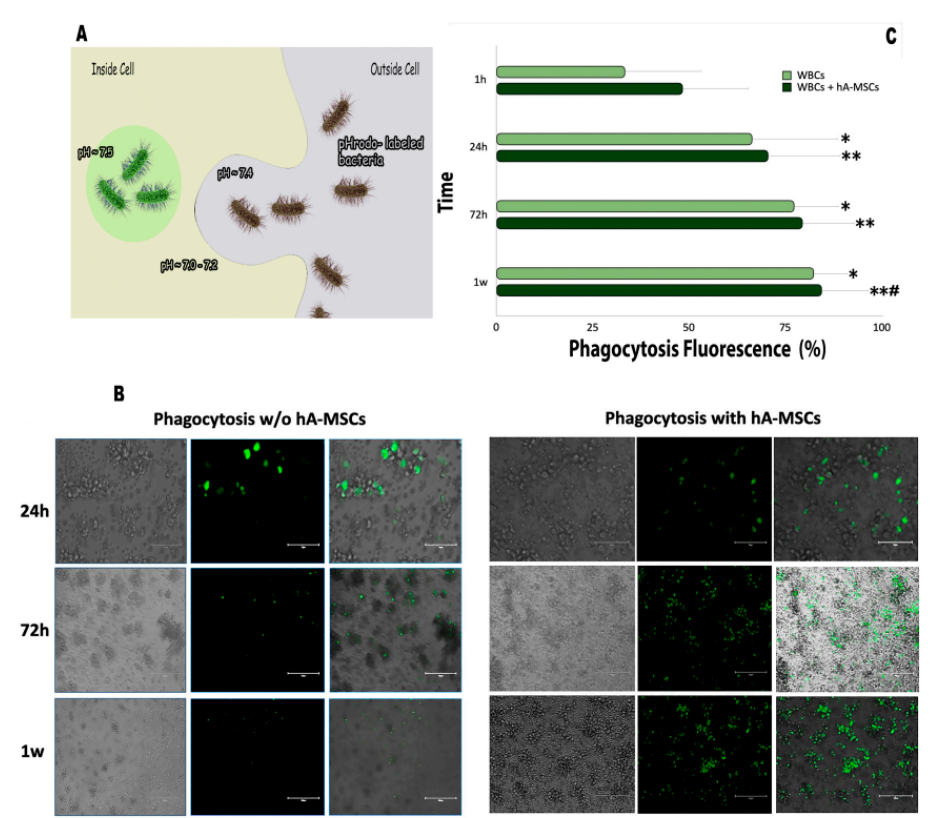
Figure 5. ( A ) A representative image for phagocytosis of pHrodo-labeled E. coli bioparticles, which are nonfluorescent at neutral pH, but fluorescent (bright green) in acidic environments. This increase in fluorescence signal is directly correlated to engulfment of pH sensitive dye-conjugated bioparticles and occurs at low pH. ( B ) Detection of phagocytosis cells using pHrodo™ Green E. coli BioParticles ® . The panel of fluorescence pictures shows WBCsAF grown, with or without hA-MSCs, after 1 h, 24 h, 72 h, and 1 week. Fluorescence can be observed from 72 h onwards in presence of hA-MSCs, indicating high levels of phagocytosis, when compared to samples not treated with hA-MSCs. Scale bar, 150 µ m. ( C ) Effects of hA-MSCs on phagocytosis of E. coli BioParticles by WBCsAF. Statistics were obtained comparing with 1 h (*) and 24 h (#). Values were statistically significant when p < 0.05 (*, #), p < 0.01 (**), and are expressed as means of percentages and SD. Phagocytosis of the particles